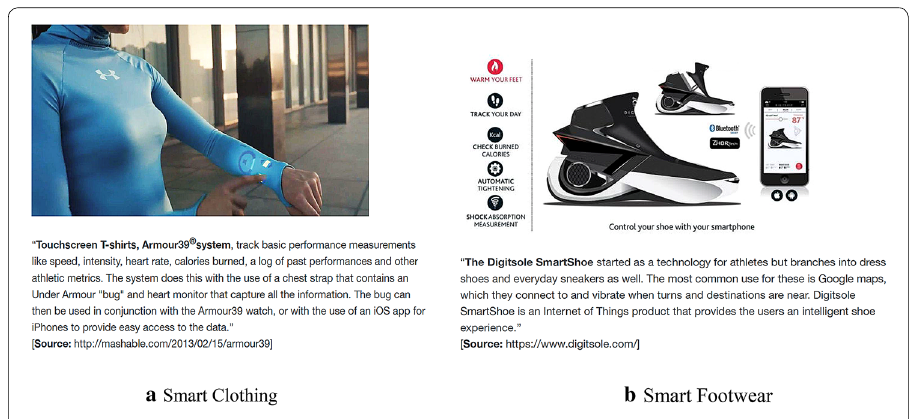
Fig. 1 Stimuli used for smart clothing and